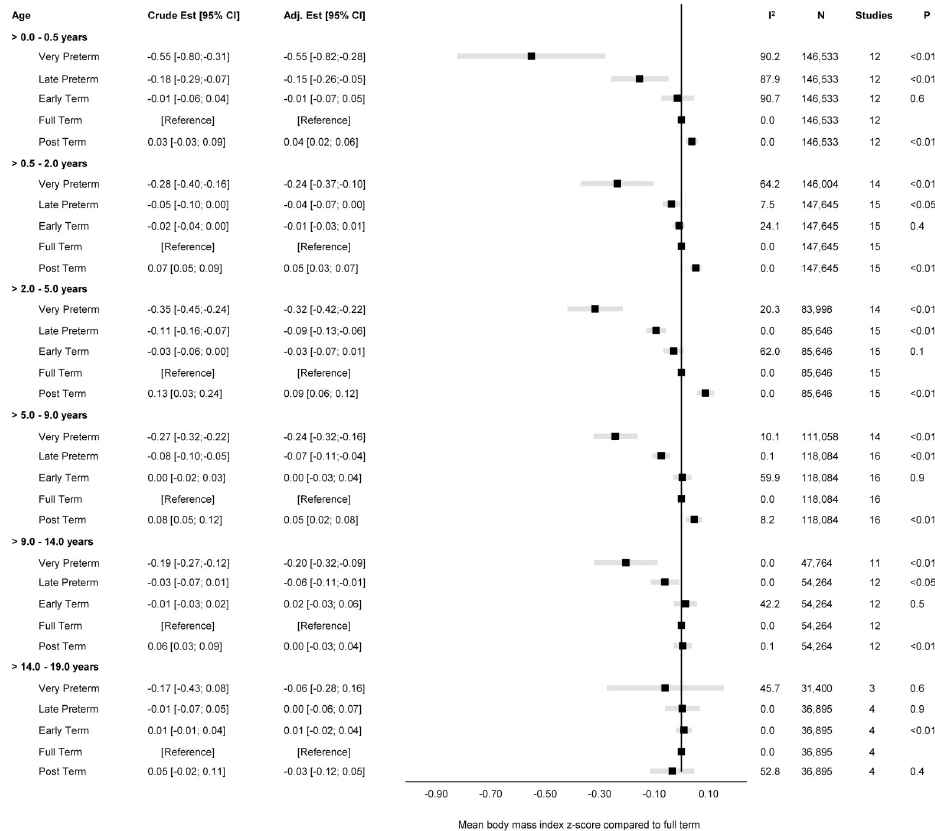
Fig 2. Forest plot of associations between GA (clinical categories) and BMI z-score. Overall unadjusted and adjusted estimates with 95% CIs from IPD meta-analyses of the study-specific linear regression models, where cohorts were assigned weights under the random-effects model. The dot in the forest plot represents the adjusted estimates, while the whiskers span the 95% CI, whereas I 2 -statistics (I 2 ), sample size (N), studies, and p -value (two-sided, < 0.05) relate to adjusted estimates. Estimates reflect a mean BMI z-scores compared to full term (reference category) in early infancy ( > 0–0.5 years), late infancy ( > 0.5–2.0 years), early childhood ( > 2–5 years), mid-childhood ( > 5–9 years), late childhood ( > 9–14 years), and adolescence ( > 14–19 years). Models are adjusted for sex of child, and the following maternal characteristics: age at child’s birth, education, height, prepregnancy BMI, smoking during pregnancy, parity, ethnic background, gestational diabetes and hypertension, and preeclampsia. Cohort-specific estimates were adjusted for the maximum available set of the confounding variables (see Table 1). BMI, body mass index; CI, confidence interval; GA, gestational age; IPD, individual participant